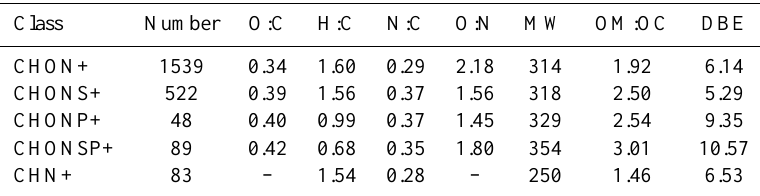
Table 2. Number of compounds in each compound class and the average (arithmetic mean) elemental ratios for each compound class in all 7 marine rainwaters (compounds that do not contain N in their elemental formula are not included). The average molecular weight is denoted by “MW” and the average double bond equivalents by “DBE” as in the text.